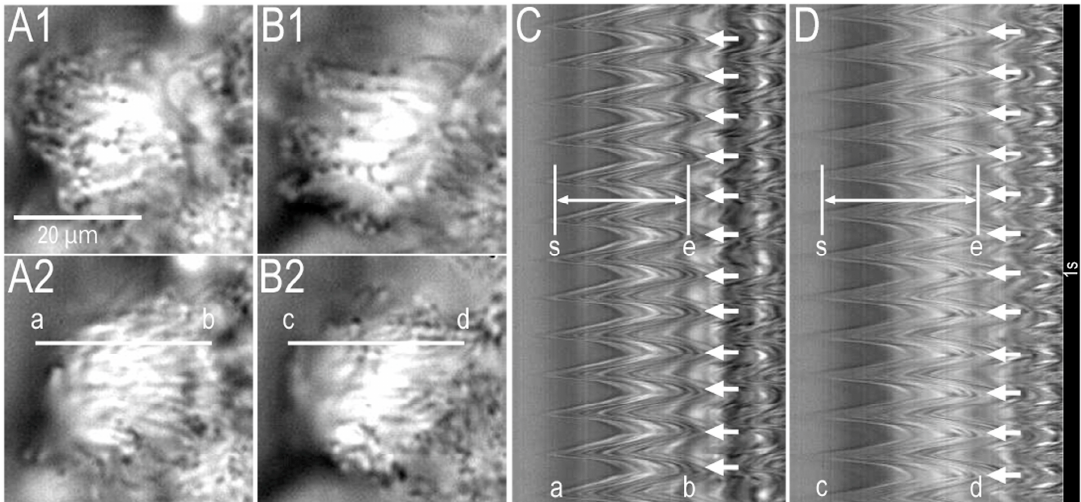
Figure 1. Video images of ciliated human nasal epithelial cells (cHNECs) in primary culture (apical view). The cHNECs were perfused with the CO 2 /HCO 3 − -free control solution. ( A ) Just before daidzein stimulation. ( B ) 15 min after daidzein stimulation (100 µ M). Panels A1 and A2, and panels B1 and B2, show the start and the end of an effective stroke in a ciliary beating cycle, respectively. We set the lines “a–b” (A2) and “c–d” (B2) on the same beating cilia of a cHNEC in the video image to calculate the light intensity changes using the analysis program. ( C ) Changes in the light intensity of the line a–b ( A2 ) in an unstimulated cHNEC. The image of light intensity changes enabled us to measure ciliary beat frequency (CBF) and ciliary beat distance (CBD). The two white lines in panel C show both the start (“s”) and the end (“e”) of an effective stroke. We measured the distance (pixels) from the line “s” to the line “e” as CBD. The number of arrows (right side) shows CBF. ( D ) Changes in the light intensity of the line “c–d” in the cHNEC 15 min after daidzein stimulation (100 µ M). Daidzein stimulation